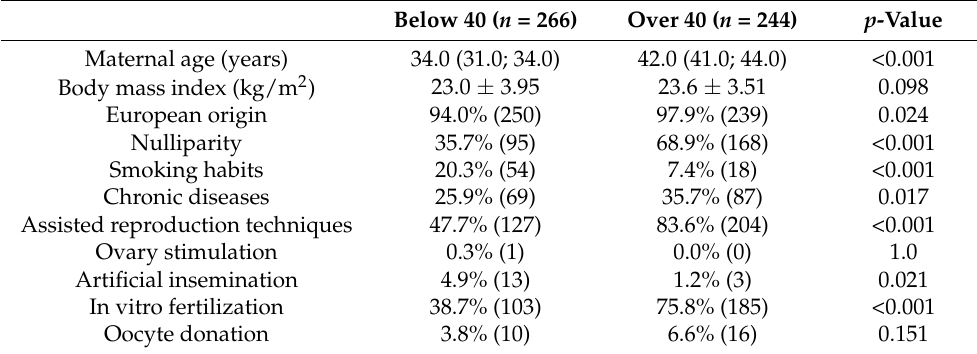
Table 1. Maternal characteristics and assisted reproduction techniques.